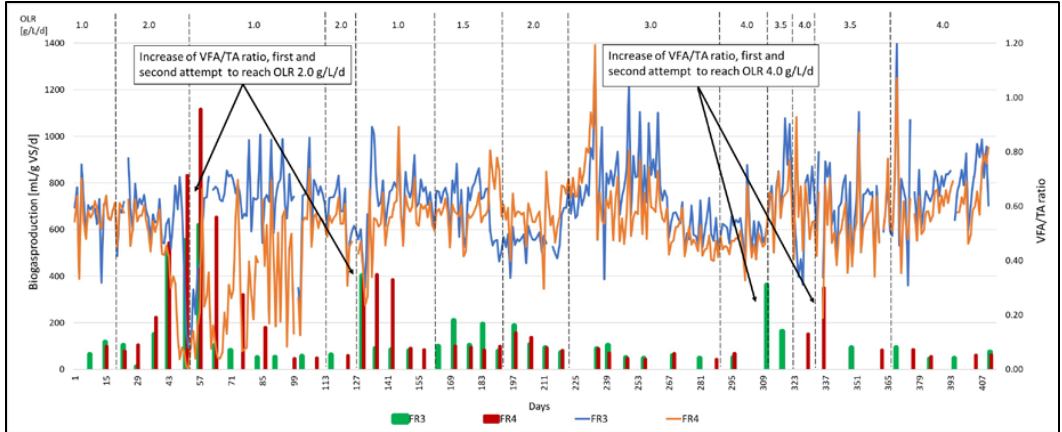
Figure 5. Biogas and VFA production, two identical reactors fed with only OFMSW during CTES-dosing. The different OLR:s are shown in the upper part of the figure. The blue and orange lines represent the biogas production (left y-axis) while the red and green staples represent the VFA/TA ratio (right y-axis). The periods where the VFA/TA ratios increased to high levels are pointed out with arrows.